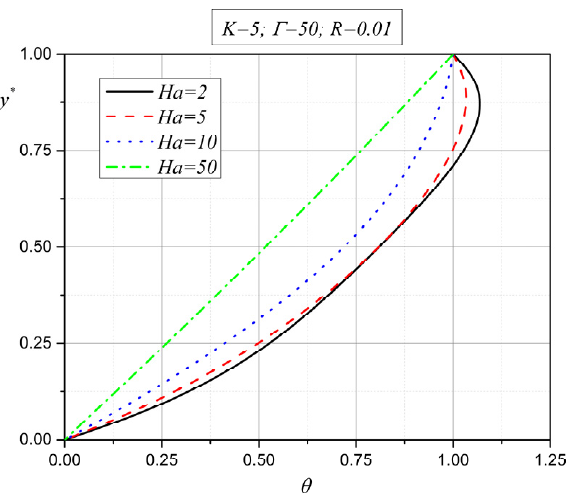
Figure 10. Dimensionless temperature θ as a function of Hartmann number.